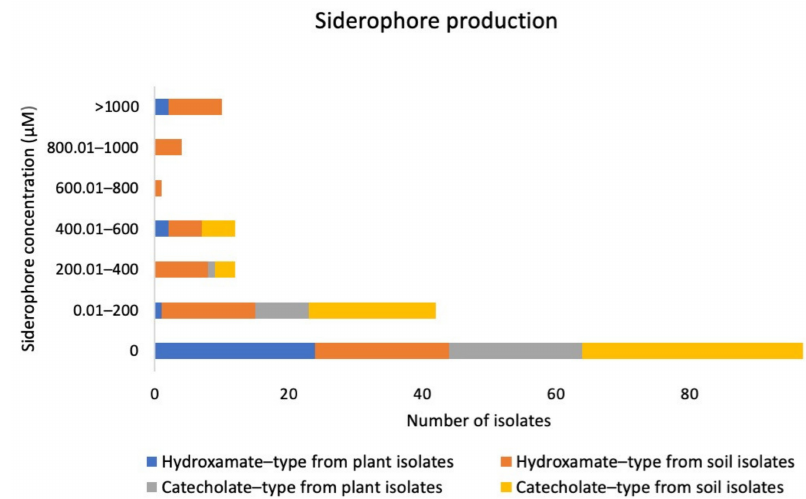
Figure 2. Siderophore production of actinobacteria associated with mosses. Table 2. Actinobacterial isolates capable of phosphate solubilization. Data for each isolate is based on three repeats ( n = 3). a–d : isolates with different letters indicate statistically significant differences as determined by SPSS one-way ANOVA and Tukey HSD test ( p < 0.05). Source Host Moss Species Isolate Clear Zone on PVK Agar (cm)